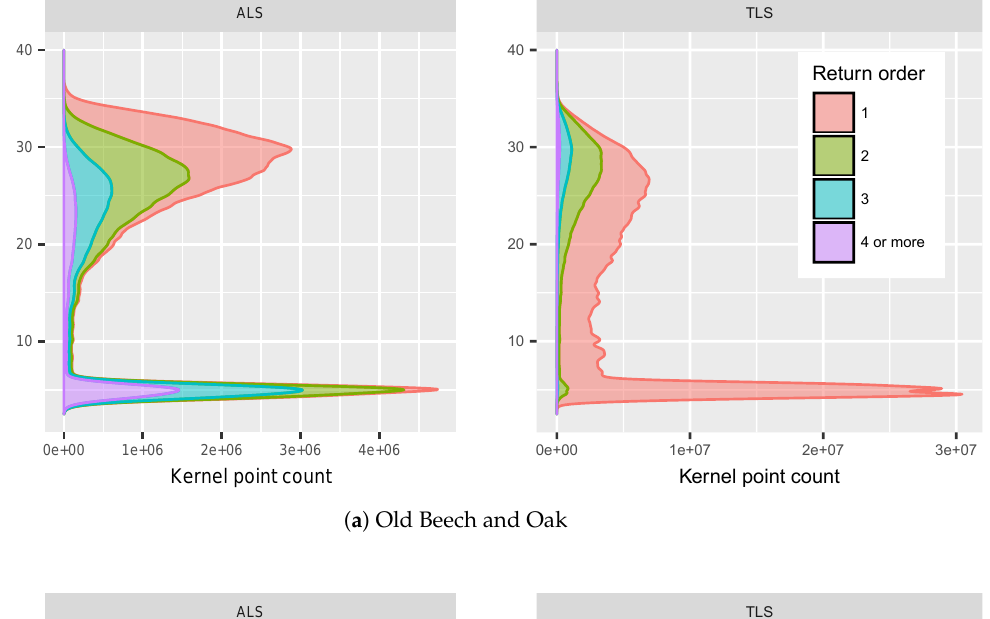
Figure 7: extreme cases can be found along the x and y axes. They represent cases when either the ALS or the TLS hit the crown and the other the ground. Outliers along the x and y axis represent mainly the western and eastern crowns sides, respectively. Nonetheless, all scatterplots confirm the high agreement of ALS and TLS. However, similar to the vertical profiles (Figure 5) also in the case of the CHMs ALS tended to detect higher points in the canopy, resulting in overall higher CHM. For instance, the ALS CHM was 6.1 cm and 12.2 cm higher for the Giant Fir and Old Beech and Oak plots, respectively. The difference for all cells over all plots was 11.5